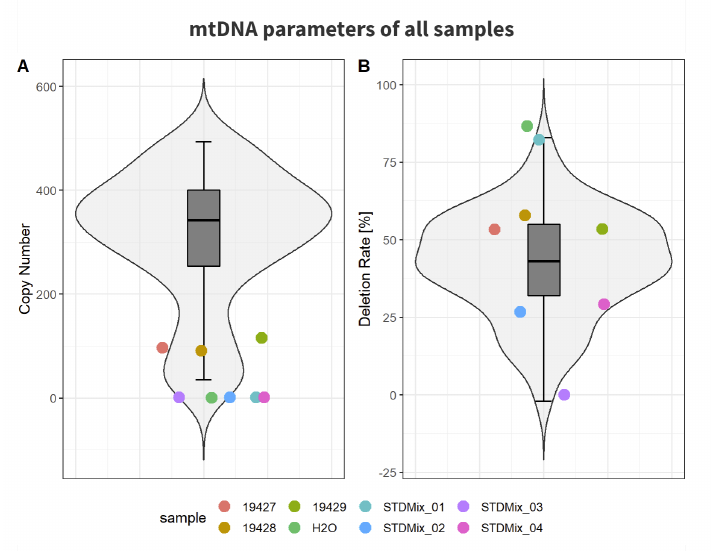
Figure 5. Violin plot showing non-production example results. To show the age-dependency of the mtDNA parameters and compare the samples in the current analysis run to reference intervals, age (on the x -axis) can be plotted against mtDNA CN and mtDNA DR values (on the y -axis) (Figure 6). A regression line shows the age dependence of the data contained in the reference file. The gray background shows the 95% confidence interval of this reference data, while the data from the current analysis run are depicted in colored dots on top. The same example data were used as in Figures 4 and 5.